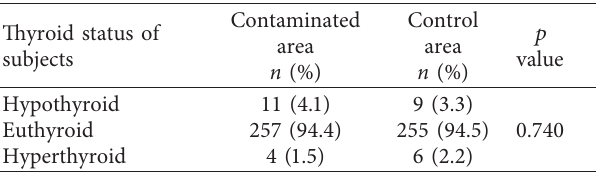
Table 4: Thyroid status of subjects from the contaminated and control areas (Univariate